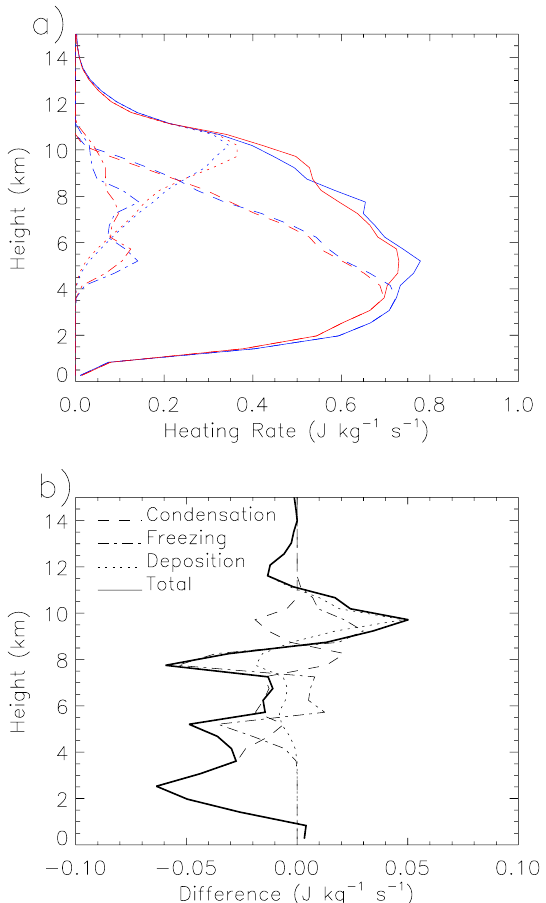
Fig. 12. As in Fig. 11, except for the configuration with latent heating due to freezing of cloud liquid water and rain turned off (NOFRZ